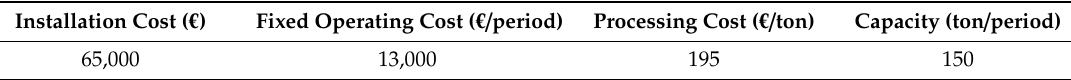
Table 1. Parameters of temporary transit centers.